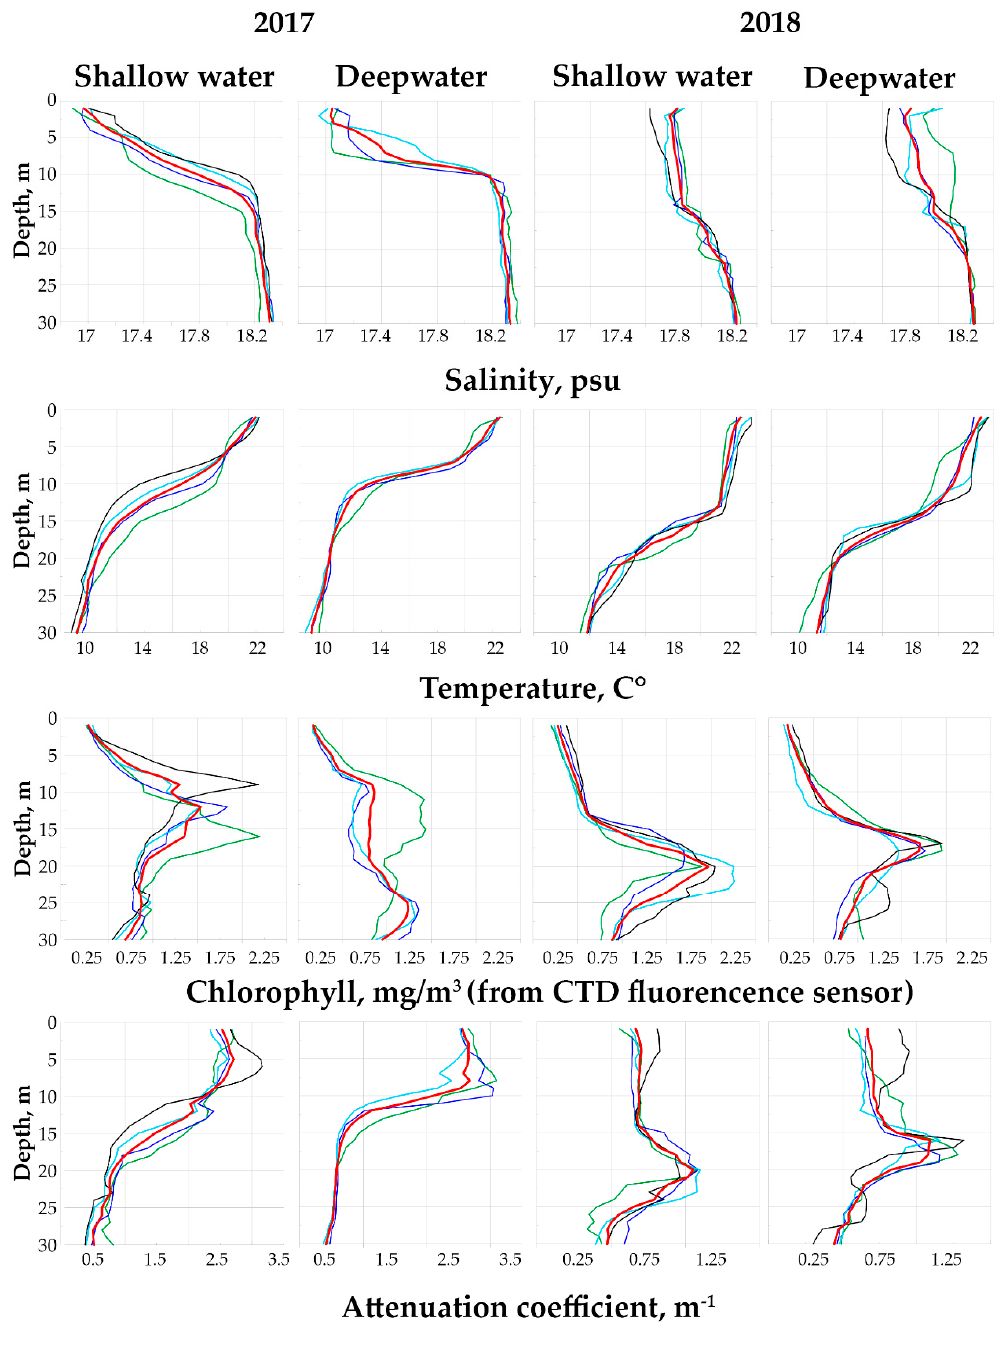
Figure 9. Daily profiles of the main characteristics for shallow-water (25–80 m) and deep-water (from 300 to 1500 m) stations. The averaged profiles are shown in red. The data obtained in 2017 were for 8 June (green), 9 June (blue), 10 June (cyan), and 11 June (black); the data obtained in 2018 were for 5 June (green), 6 June (blue), 8 June (cyan), and 9 June